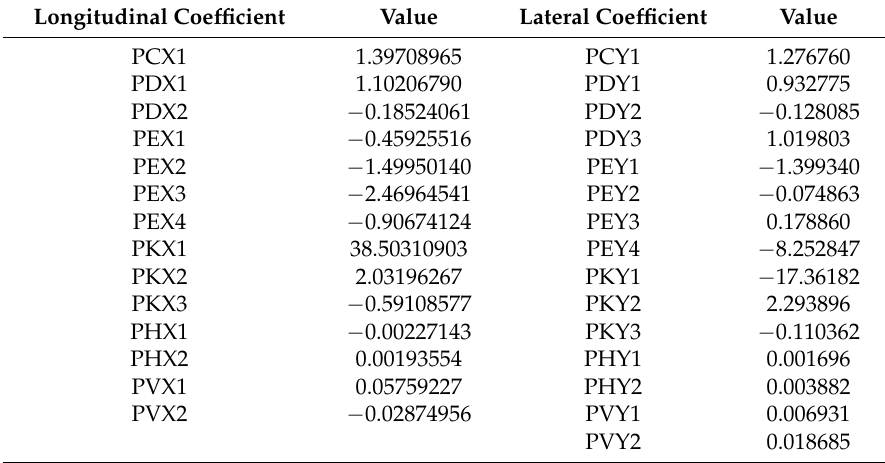
Table 2. Parameters for pure longitudinal and lateral force [19]. Tire 205/65R15. Longitudinal Coefficient